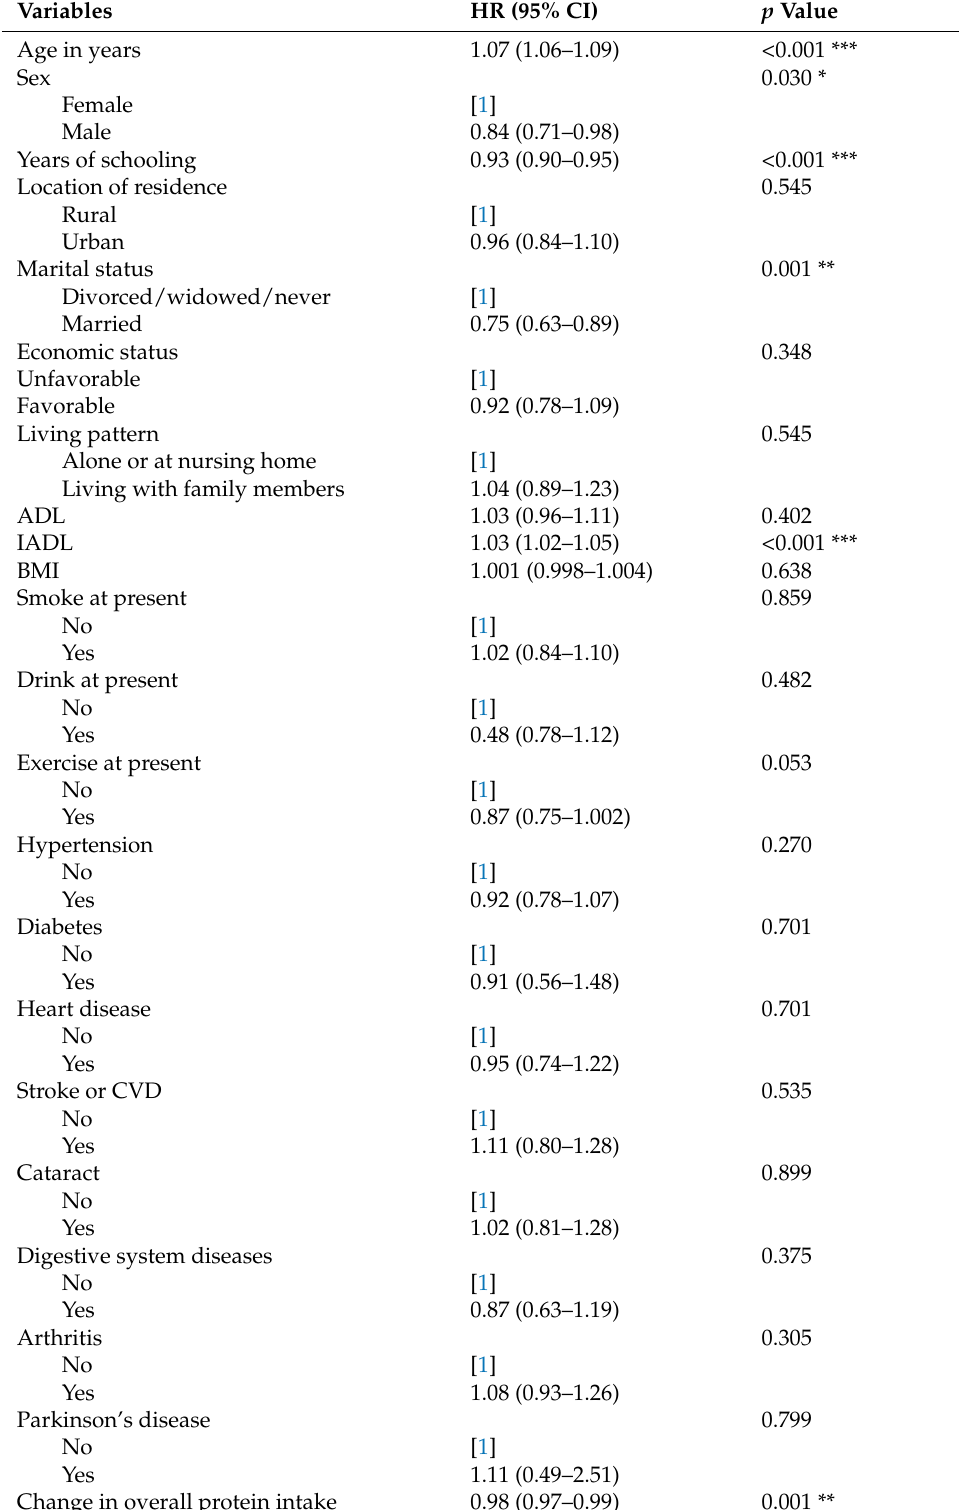
Table 2. The association between all variables and cognitive